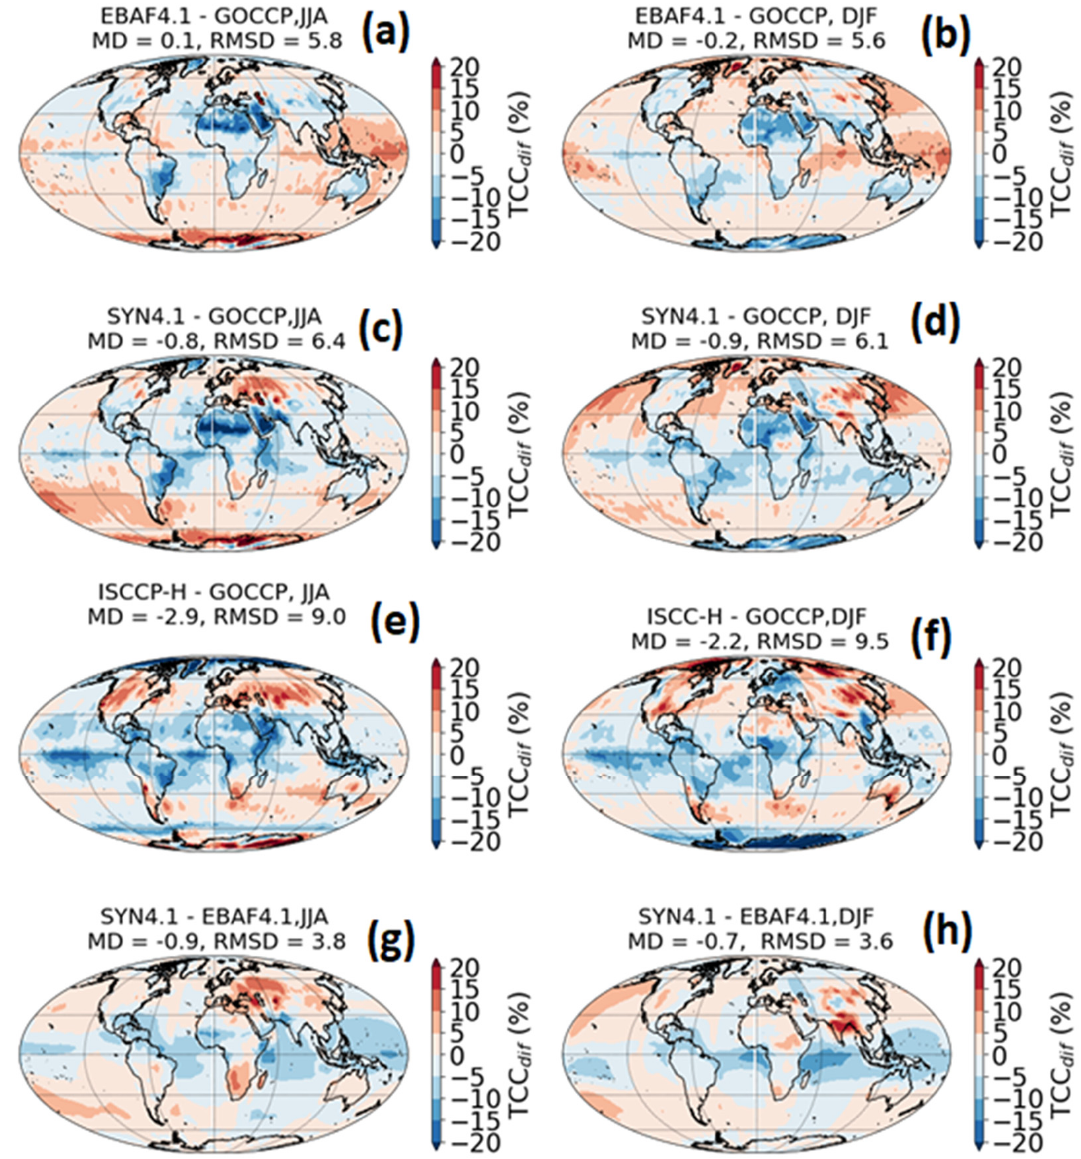
Figure 7. Global maps of bias of annually and seasonally averaged TCC and root mean square deviation (RMSD).